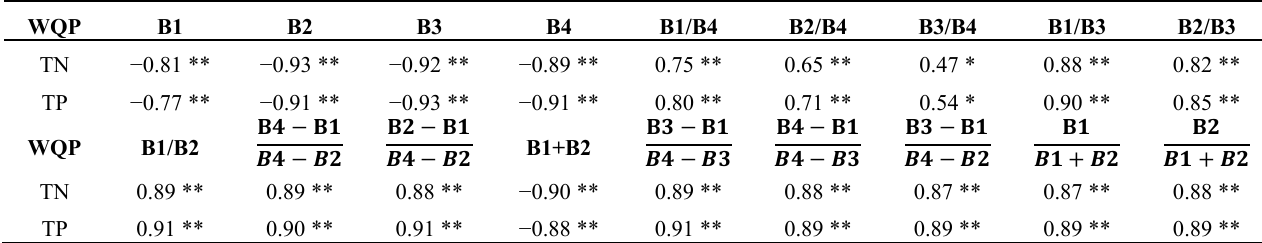
Table 5. Pearson’s correlation coefficient among TN and TP with IKONOS bands and band